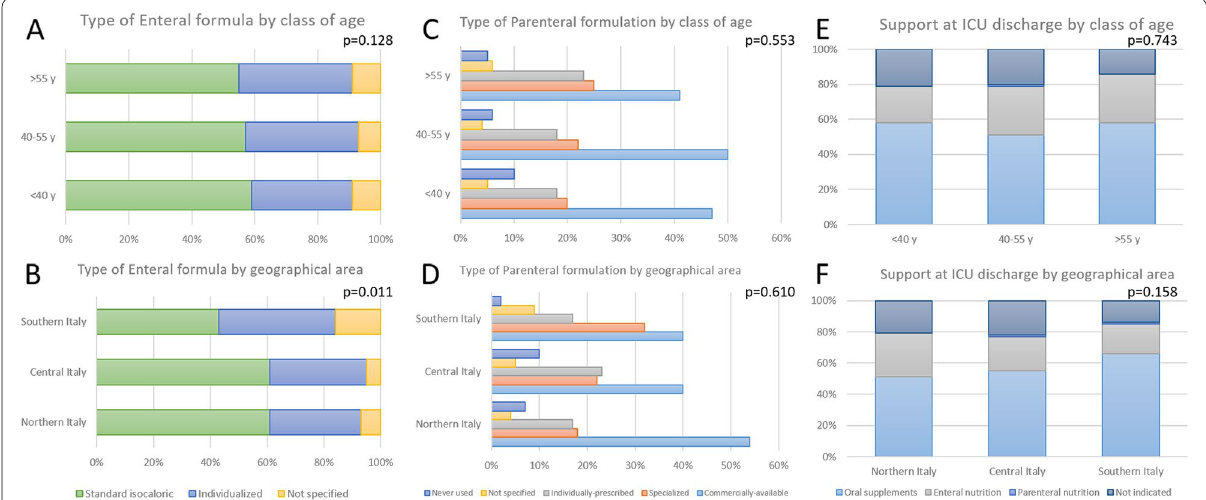
Fig. 3 Relationship between the type of enteral formula (left panel), parenteral formulation (middle panel), and type of support at ICU discharge (right panel) and the class of age (upper) and geographical area (lower) of the